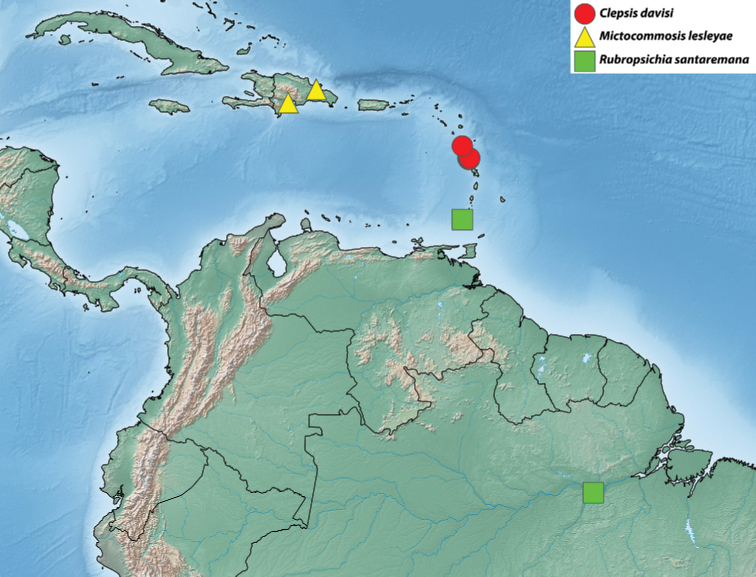
Clepsis, Mictocommosis and Rubropsichia species distributions. Legend inset.